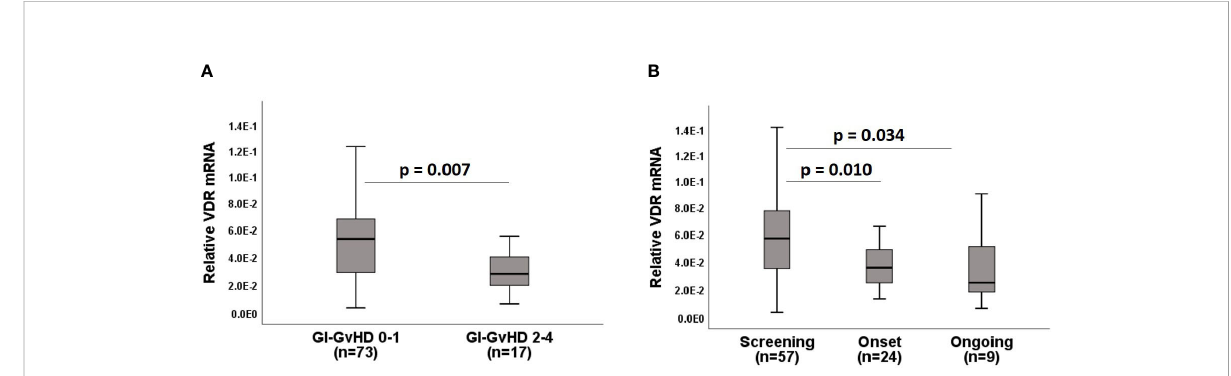
FIGURE 1 Expression of VDR mRNA in acute GI-GvHD. (A) VDR mRNA expression with respect to the histological classi fi cation of acute GI-GvHD. (B) Expression of VDR mRNA with respect to the clinical classi fi cation of acute GI-GvHD. Box plots represent median, upper and lower quartile and whiskers indicate minimal and maximal values. p value, Mann-Whitney U